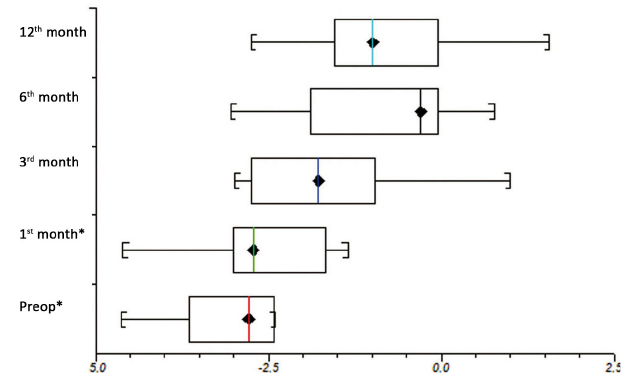
Fig. 6 - Evolution of z-scores for brachial perimeter/age (BPAZ) in cardiac patients with BPAZ in the preoperative period which was below the normal pattern of development. Analysis of variance with P=0.031. (*) The BPAZ was significantly lower when compared with the general population’s in the preoperative period and the in first month